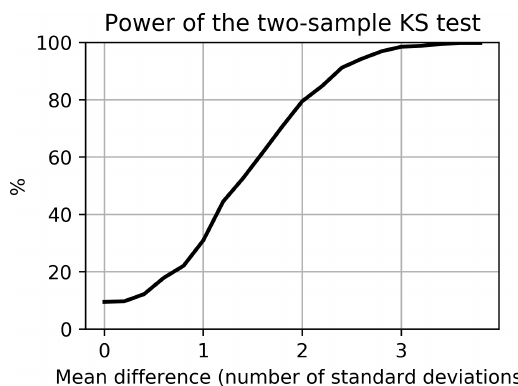
Figure 2. Power of the statistical test used indicating the probabil- ity that a two-sample Kolmogorov–Smirnov test (KS test) returns a p value below a prescribed significance level of 5%, for two five- member normal samples with equal standard deviations, and means separated by 0, 0.1, 0.2, ... 4.0 SD ( x axis) (see text for